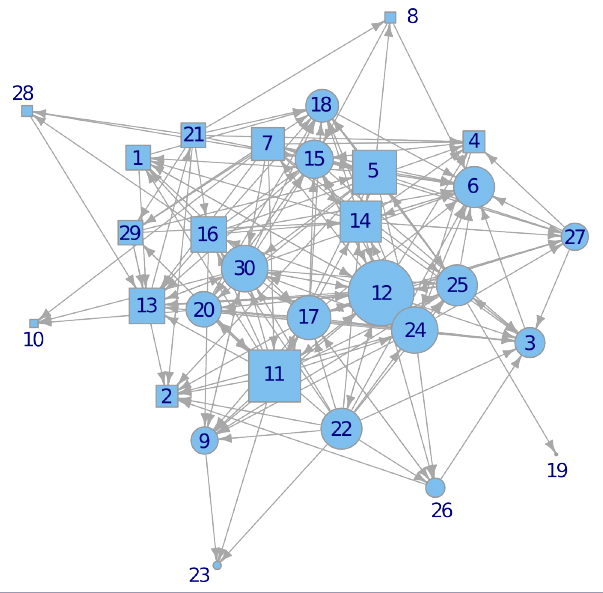
Fig. 4. Aggregate plant circulation network (density = 0.19). Women are represented by circles and men by squares. Node size is proportional to the total degree (in-degree plus out- degree).